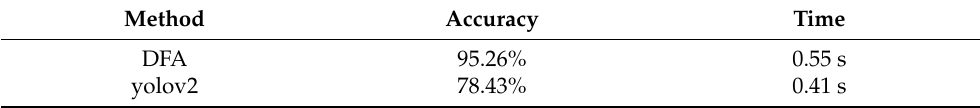
Table 4. Accuracy and time consumption